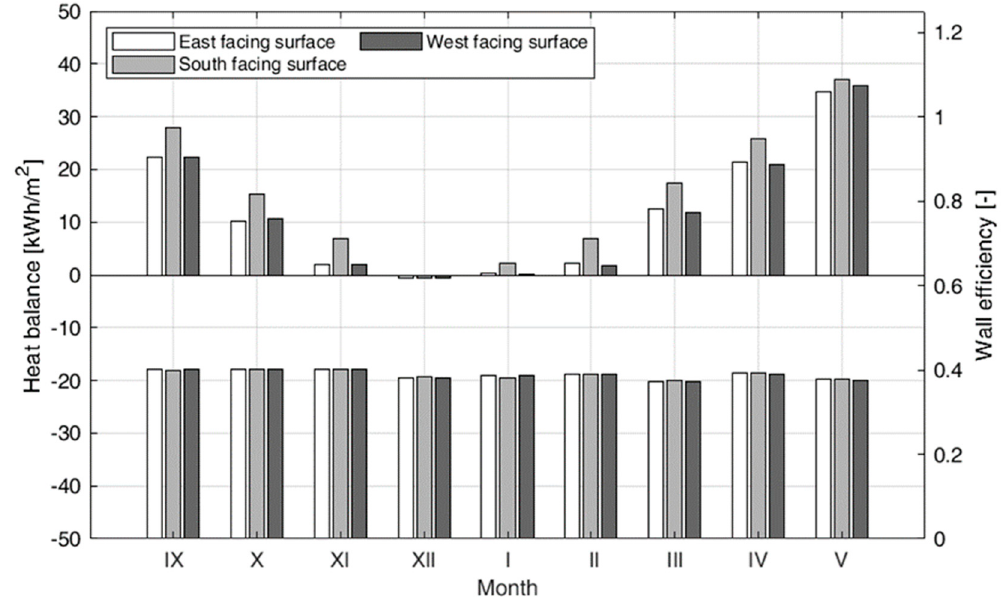
ffi ciency (bottom) of the SW-TI